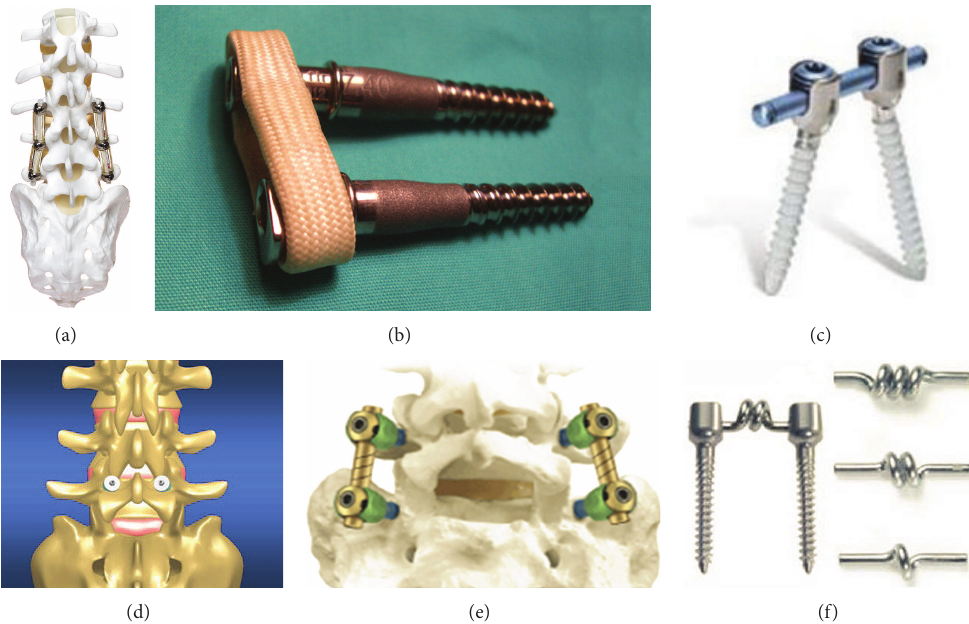
Figure 2: Posterior dynamic stabilization systems. (a) Dynesys; (b) Graf system; (c) PercuDyn; (d) Cosmic; (e) AccuFlex; (f)